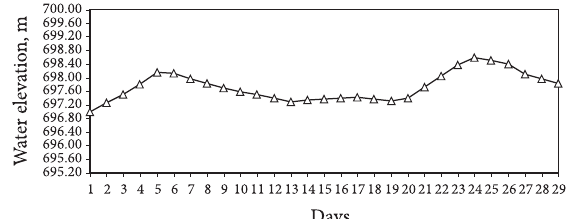
Fig. 10. Variation between reservoir water elevation and days in Goksu dam (February 2004)